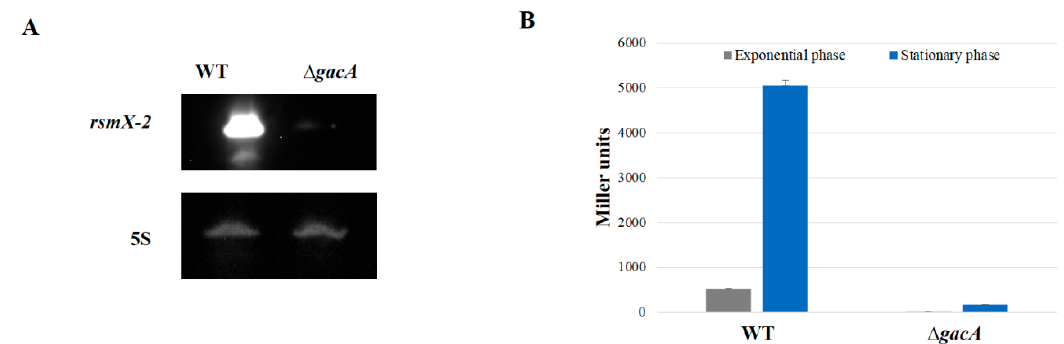
Figure 3. rsmX-2 expression is GacA dependent. ( A ) Northern blot analysis of rsmX-2 expression in WT and gacA backgrounds, 5S rRNA is used as loading control; ( B ) β -galactosidase measurements of a transcriptional rsmX-2 + 16- lacZ fusion in the WT and ∆ gacA strains.